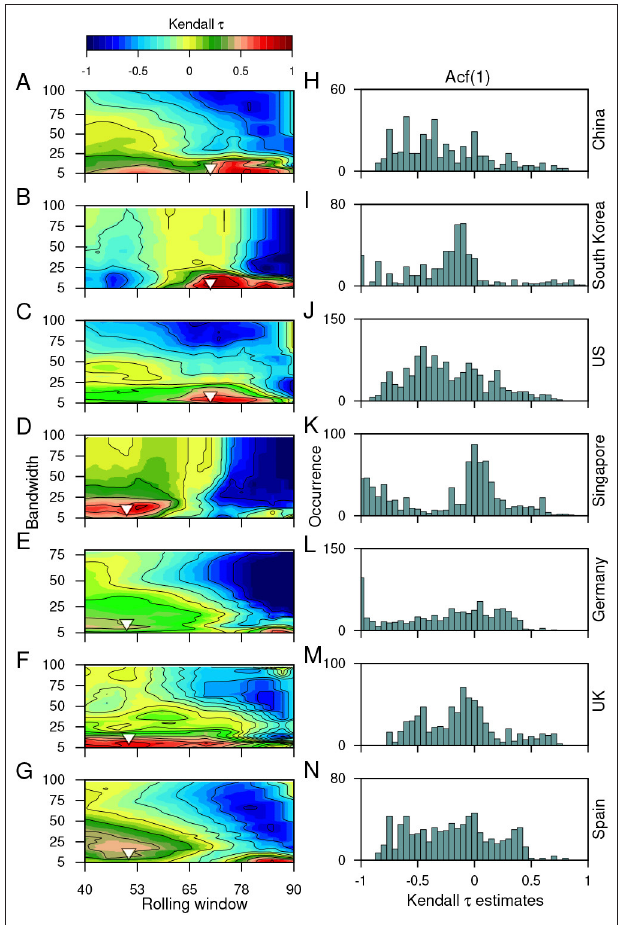
FIGURE 5 | The sensitivity of the choice of the rolling window size and the filtering bandwidth to estimate the EWSs. (A-G) : Contour plots demonstrate the effect of moving window size and the filtering bandwidth on the trends observed while calculating the short term correlation pattern using ACF(1) of the time series data, using the Kendall- τ test statistic. (H-N) : Panels on right show the frequency distribution of the trend statistic. The inverted triangles mark the choice of the filtering bandwidth and moving window size used to capture the trends in the ACF(1) of the time series